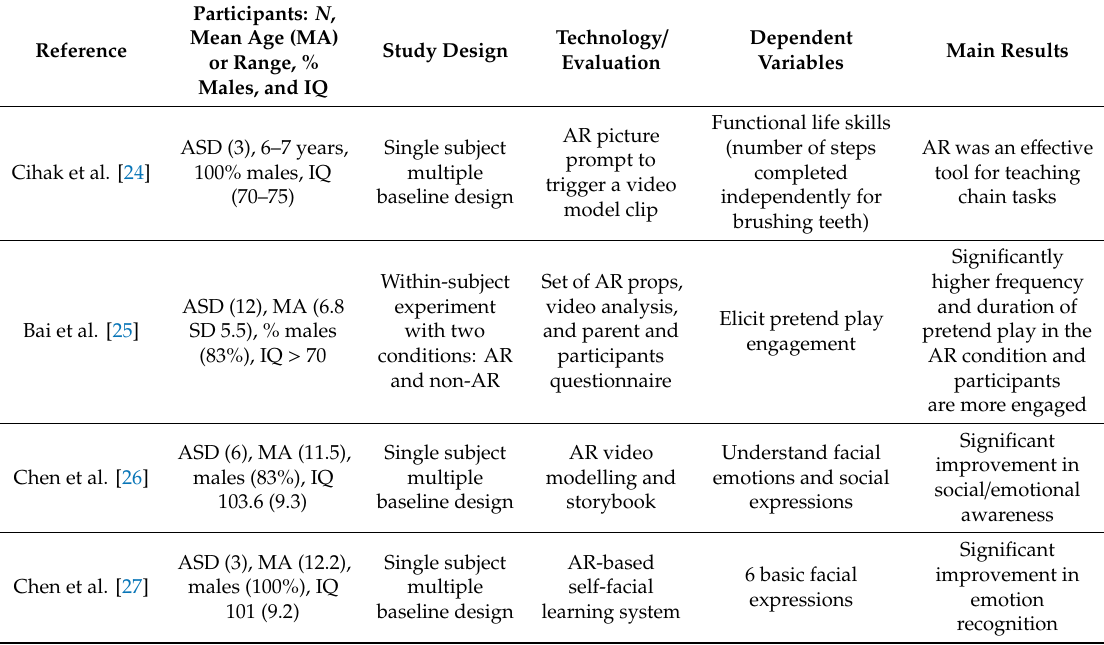
Table 1. Main characteristics of the selected studies ( N =